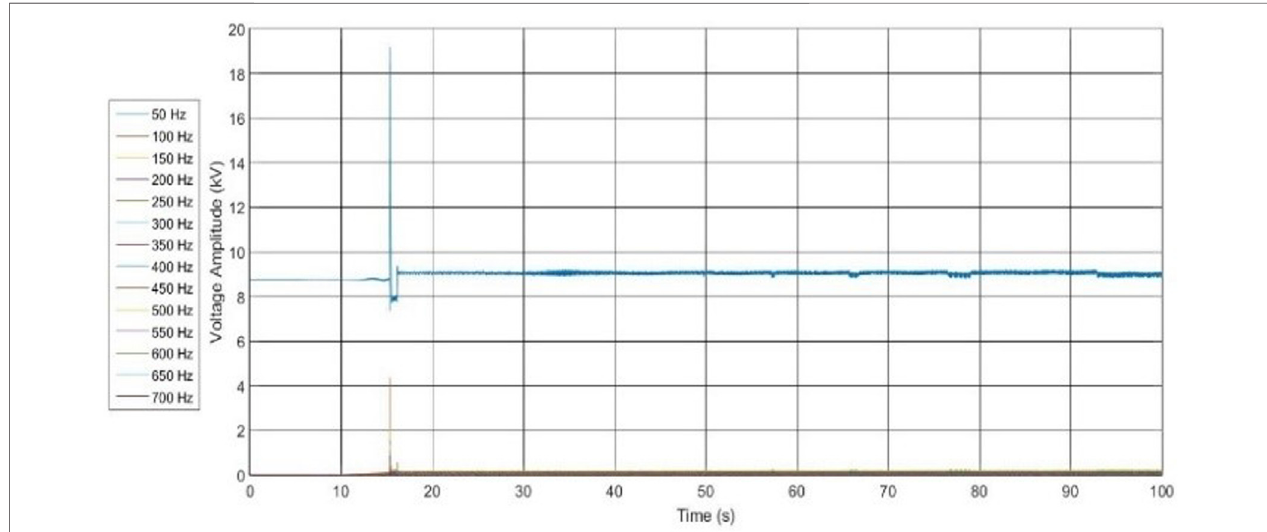
FIGURE 13 | Amplitude response of fundamental and harmonic frequencies.